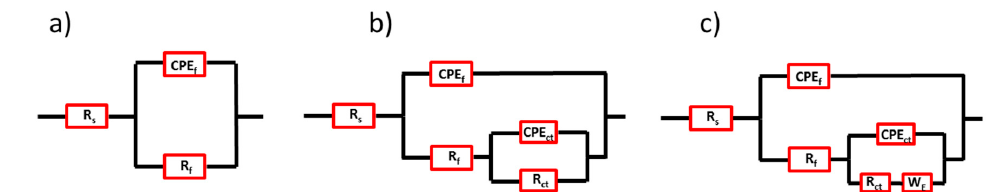
Figure 9. Equivalent circuits for EIS data of Ti, Cu and weld interface immersed in 3.5 wt.% NaCl solution: ( a ) Ti for 0 h; ( b ) Cu and weld interface for 0 h, Ti for 1 h and 6 h; ( c ) Cu and weld interface for 1 h and 6 h. Table 1. Electrochemical impedance spectroscopy parameters for Ti, Cu and weld interface electrodes in 3.5% NaCl at different immersion times.